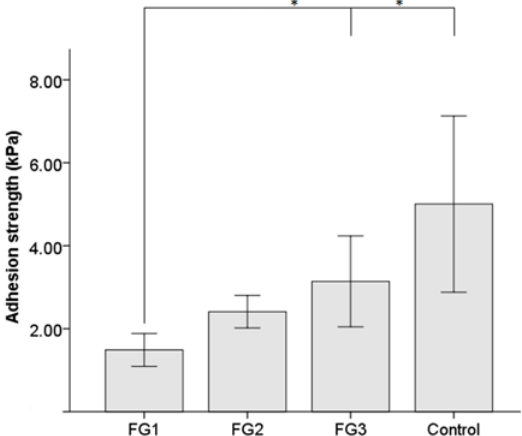
Figure 2. Mean fibrinogen concentration ( A ) and thrombin activity ( B ) obtained in FG1, FG2, and FG3, and a statistical comparison with the commercial FG as a control. **: p -value < 0.01. Data are shown as the mean ± SD. FG: bio-based fibrin glue.